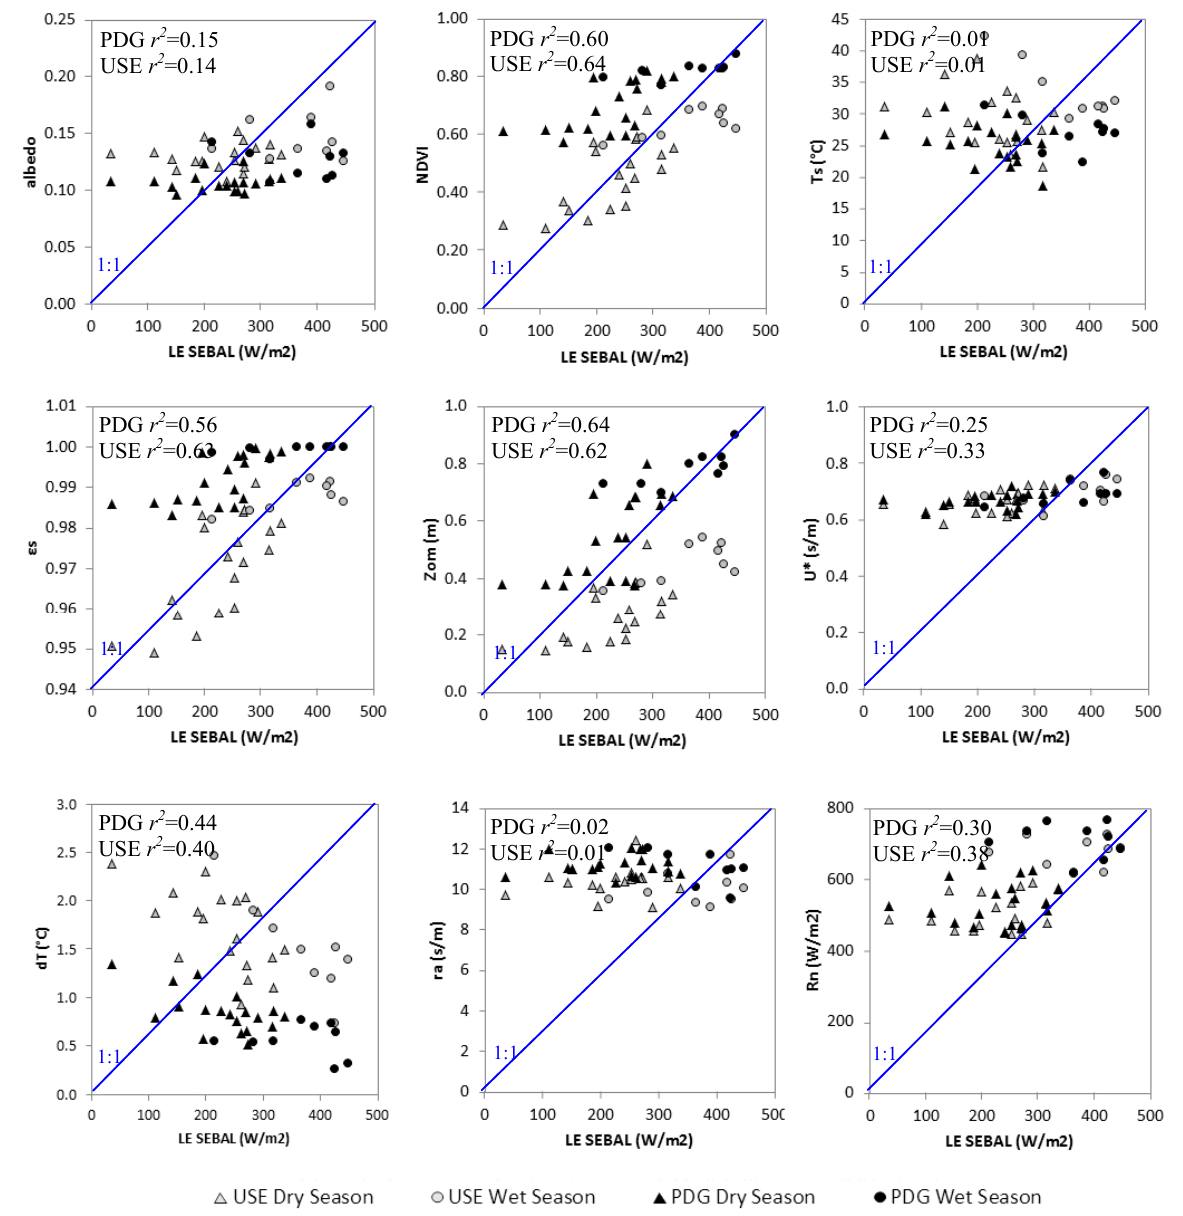
Figure 4. Correlation between inputs and intermediate variables of the SEBAL algorithm and estimated instantaneous latent heat fluxes in areas of savannas (PDG site) and sugarcane croplands (USE site) during dry and wet